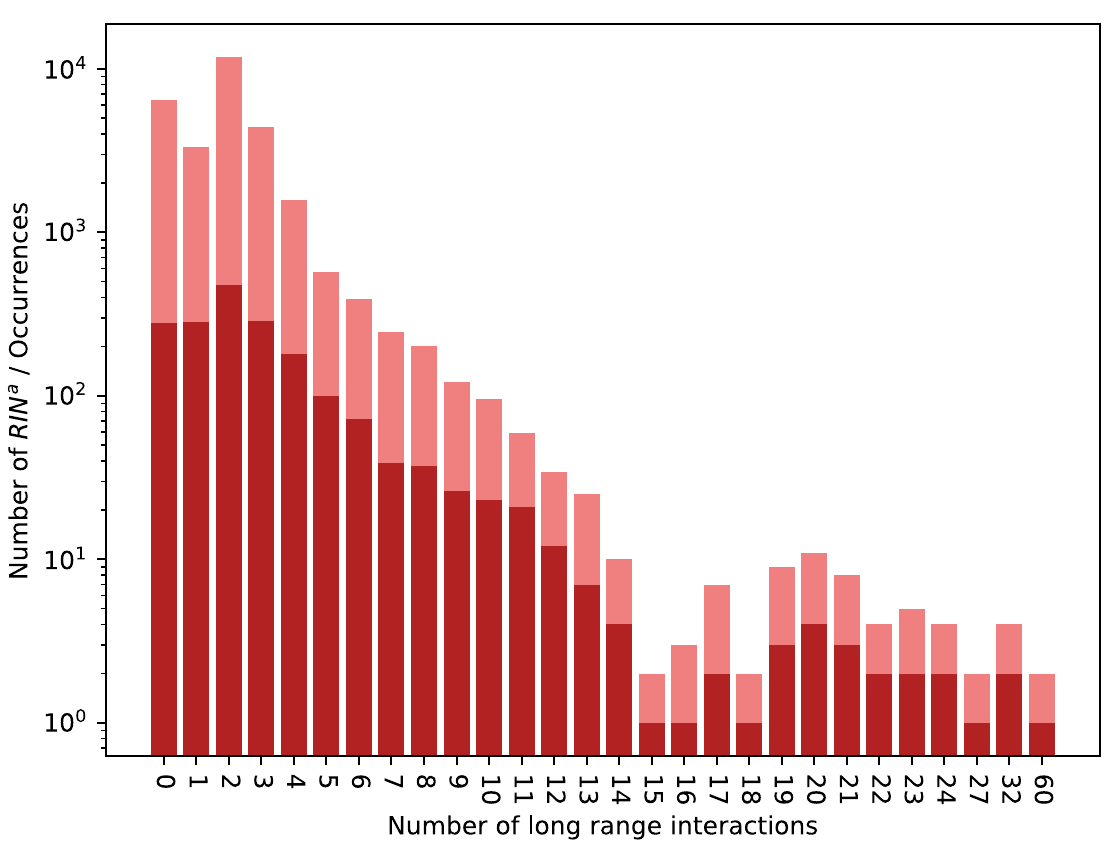
Fig 11. Distribution of RIN a in Dataset 3.137. Numbers of distinct RIN a s numbers of long range interactions they contain in Dataset 3.13.